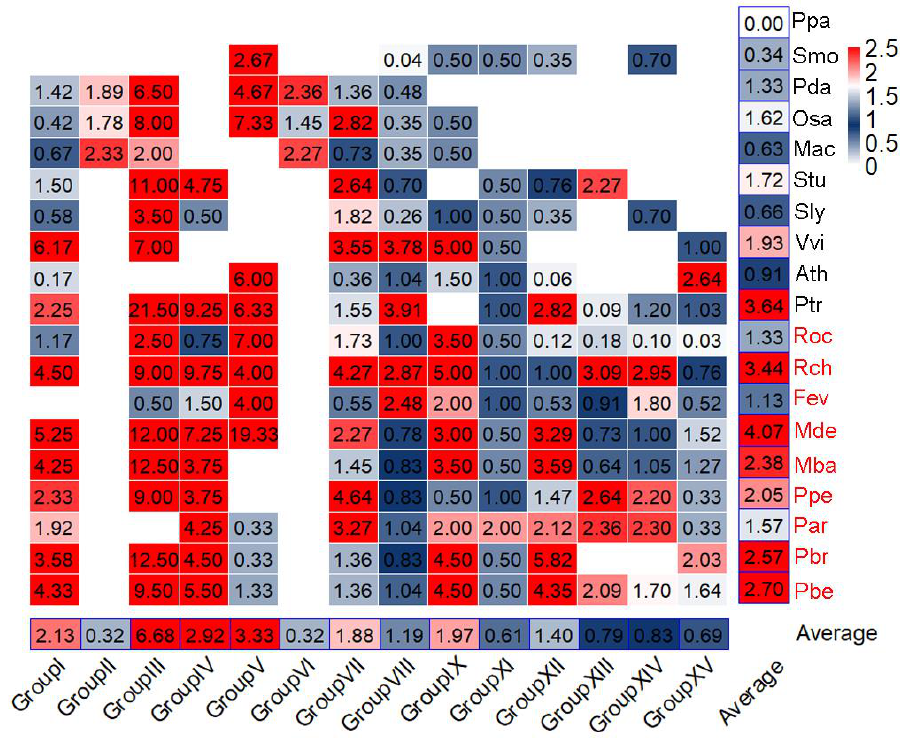
Figure 3. Global and exact expansion rates for each subfamily from 19 species. The value of each group was calculated by the member size divided by the number of ancestral genes.